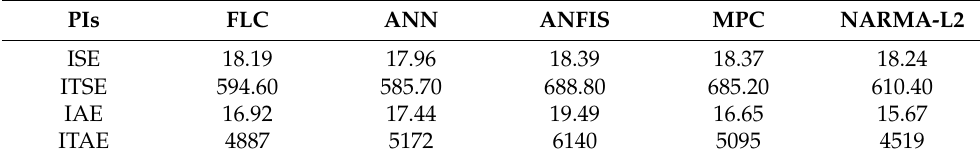
Table 8. Performance indexes for a disturbance at the input of the spherical tank.